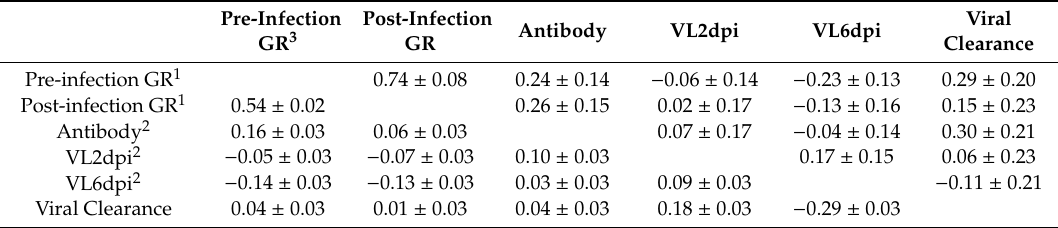
Table 3. Estimates ( ± SE) of genetic (above diagonal) and phenotypic (below diagonal) correlations based on bivariate